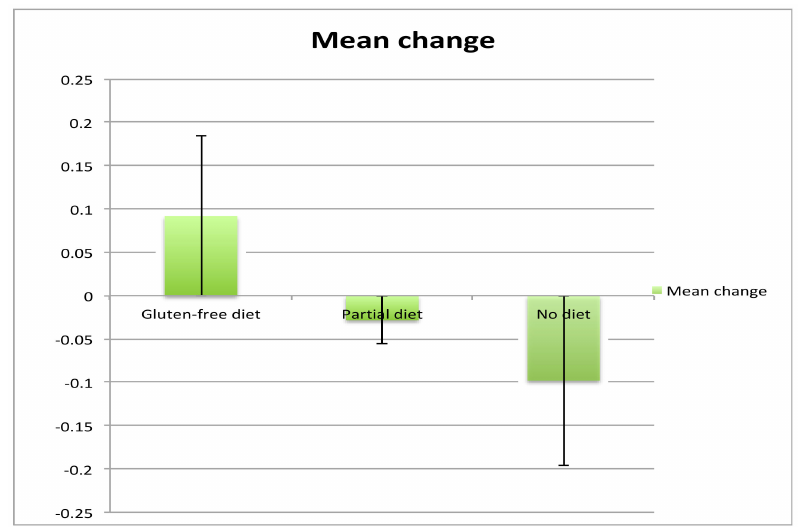
Figure 2. Mean change of the area ratio of NAA/Cr from baseline in the 3 groups.